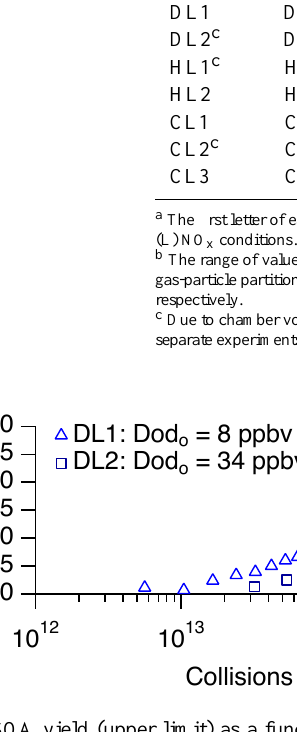
Fig. 4. SOA yield (upper limit) as a function of estimated cumu- lative SVOC-particle collisions per unit chamber volume for low- NO x dodecane photooxidation